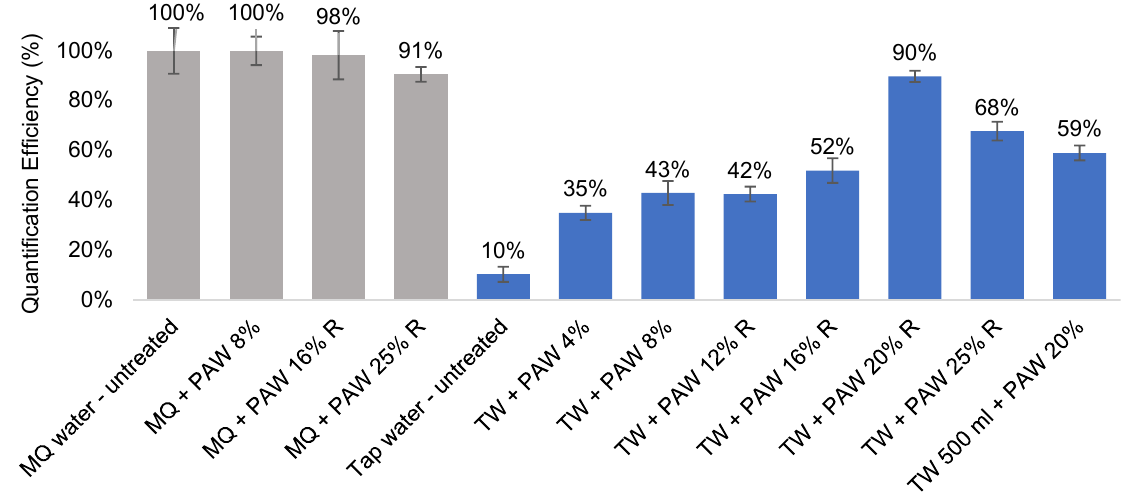
Figure 4. Effectiveness of inhibitor removal after phosphoric acid wash (PAW) treatment in 100–500 mL filter-captured C. jejuni samples. PAW—phosphoric acid wash, filters treated with 10 mL of 8–25% ( v / v ) phosphoric acid after capture. -R suffixes represented an additional rinsing step with 3 mL Milli-Q H 2 O post-wash. Grey columns—control samples with Milli-Q water (MQ) to assess effect of acid treatment on filters. Blue columns—quantification performed in spiked tap water (TW) samples of 100 mL volume, except otherwise labelled (500 mL).